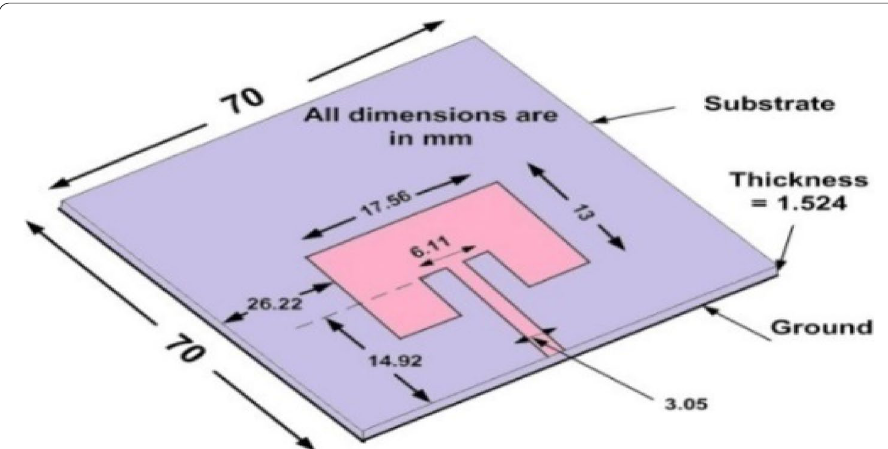
Fig. 1 Geometric structure of optimized reference microstrip patch